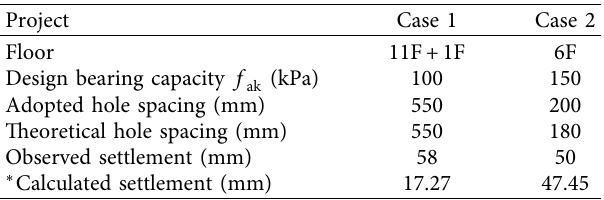
Table 1: Comparison between the practical value and the calculated